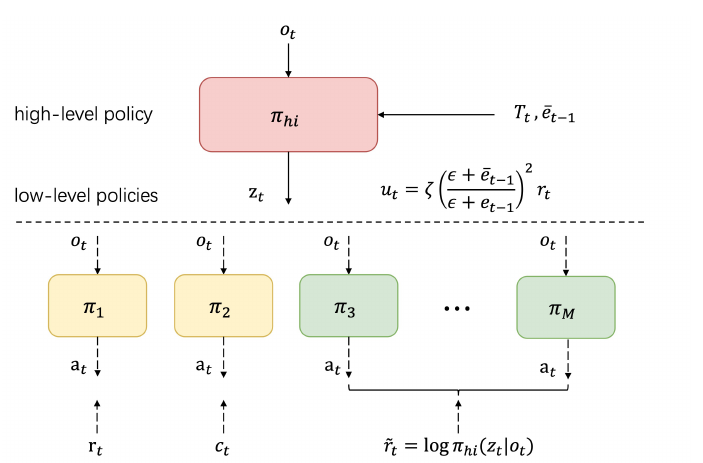
Figure 1. AHN architecture. The high-level policy π hi selects a low-level policy π i through observa- tion, and then π i performs actions to obtain rewards, while π hi obtains Admission rewards u t